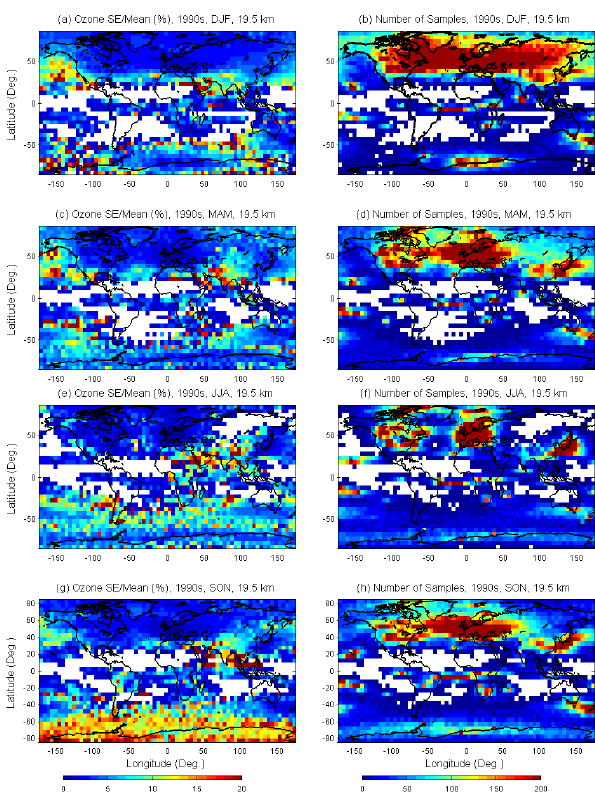
Fig. 14. The standard error of the mean (left panels) and number of samples (right panels) in the NH winter (DJF), spring (MAM), summer (JJA), and fall (SON) in the 1990s at 19.5 km.